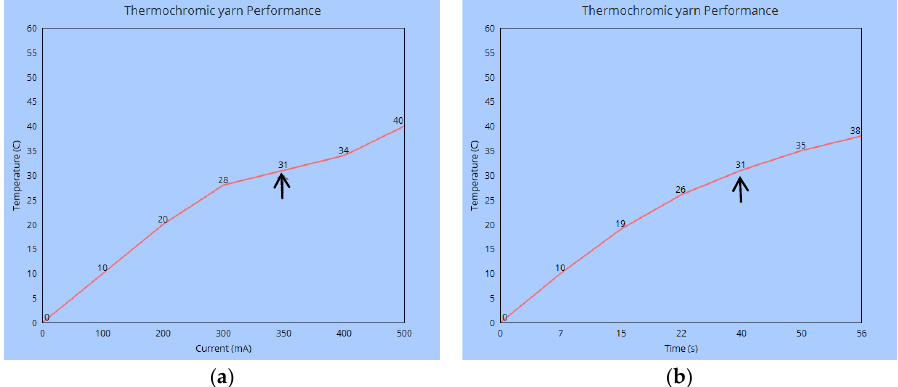
Figure 5. Performance of the composite thermochromic yarn; ( a ) temperature against current and ( b ) temperature against time. The arrows shows the colour change values.